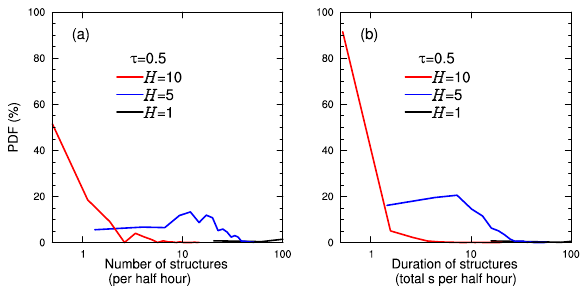
Fig. A1. Probability distribution function of (a) the kinematic mo- mentum flux contribution and (b) kinematic heat flux contribution of coherent structures for the Q-H method for a constant time fre- quency parameter ( τ = 0 . 5s) and a range of hole-sizes ( H =